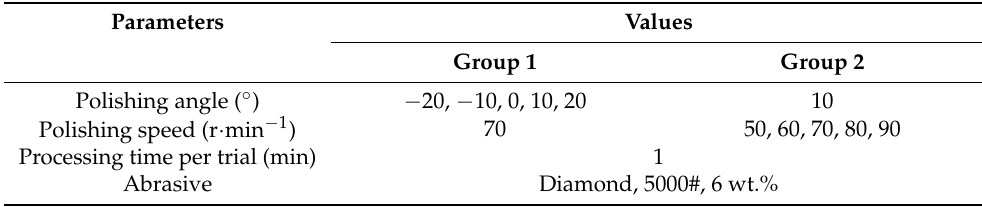
Table 2. Experimental conditions of